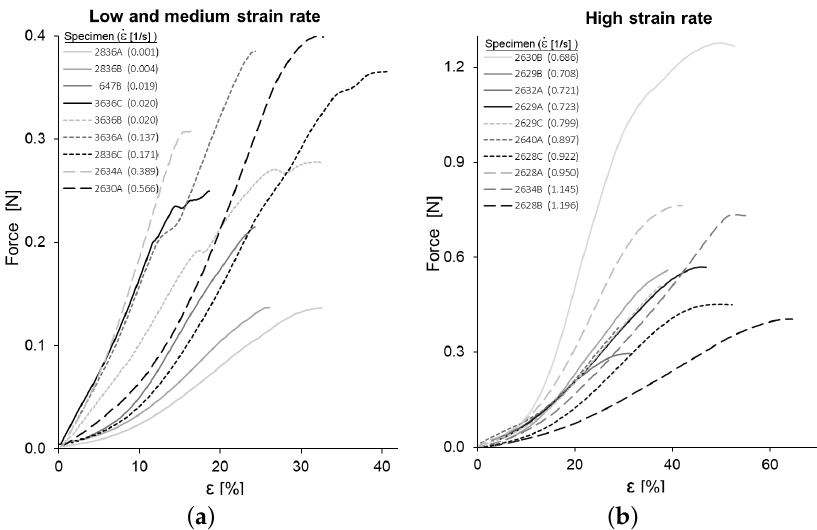
Figure 4. Force-strain curves of all specimens: ( a ) low and medium strain rate (˙ ε < 0.60 s − 1 ) and ( b ) high strain rate (˙ ε > 0.60 s − 1